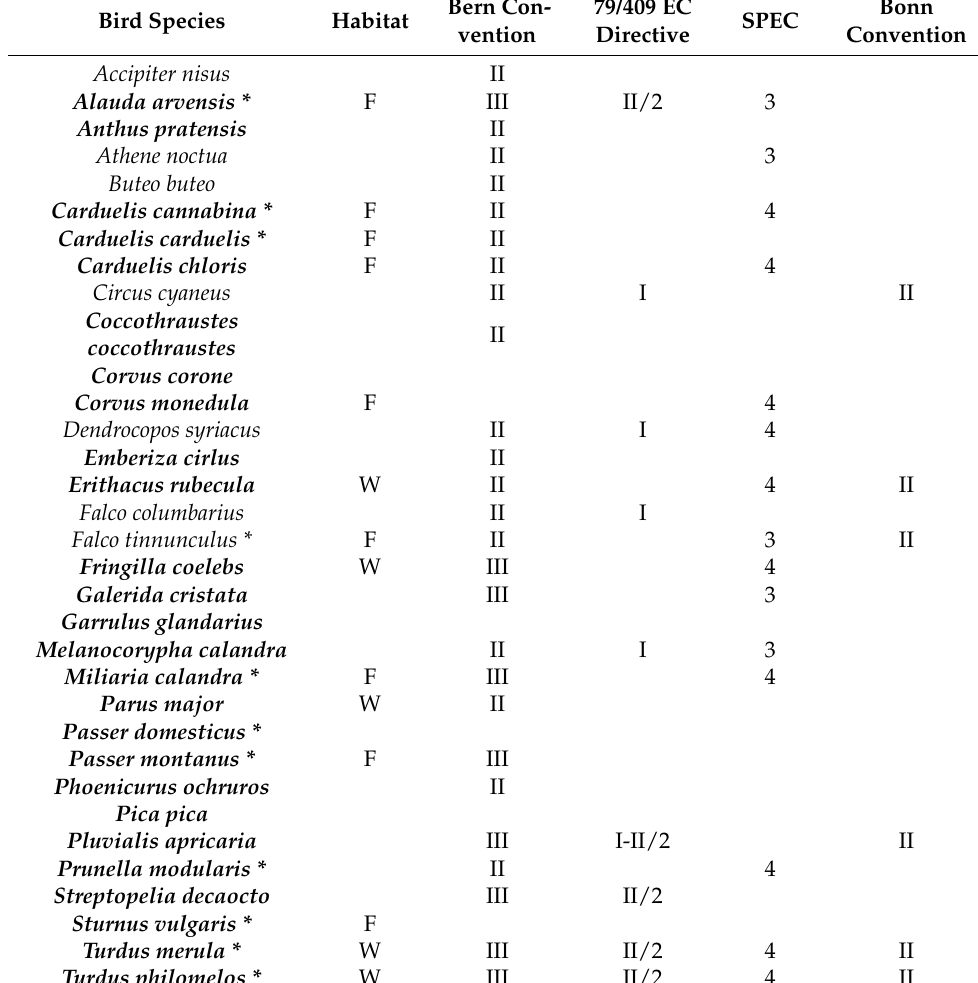
Table A3. Bird species recorded in the study area (in bold exclusively or partially seed-eaters). *: The bird species experienced decline in Europe [6,22]; F = farmland specialist, W = primarily woodland species that commonly use farmland